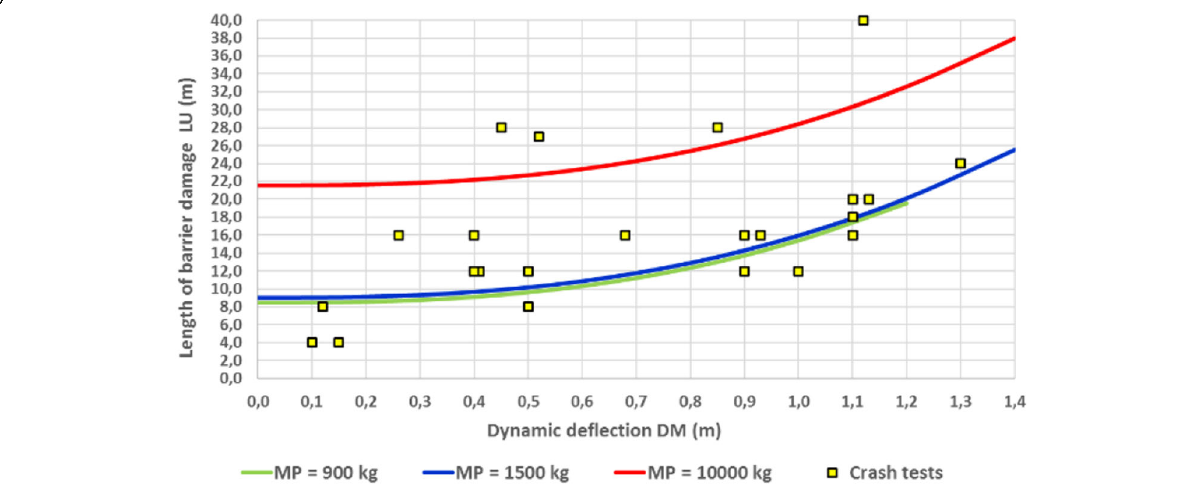
Fig. 9 Relationship between the length of damage to barrier LU and barrier dynamic deflection DM and vehicle mass MP overlaid with the results of site tests and